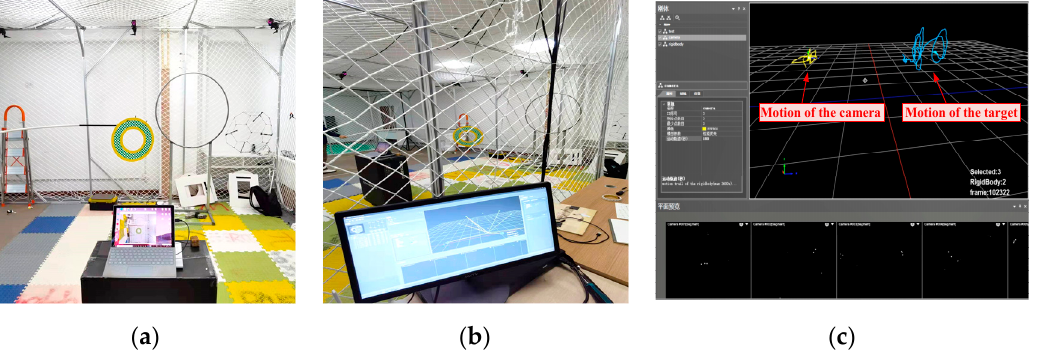
Figure 1. Measurement of indoor environment. ( a ) Collection environment of datasets, ( b ) motion- capture system monitoring station perspective, ( c ) example of the tracking interface of the motion- capture system.